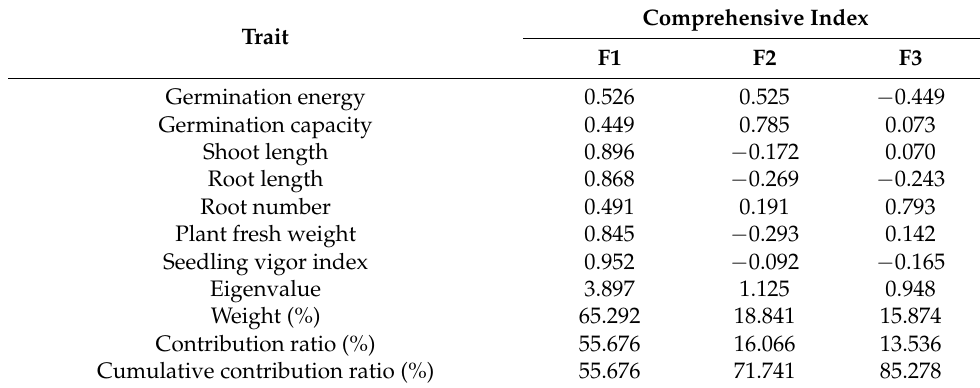
Figure 1. Determination of the optimal sodium chloride concentration for evaluating salt tolerance. The sodium chloride concentration of the salt injury index is 0.5 of the germination energy ( A ), germination capacity ( B ), shoot length ( C ), root length ( D ), root number ( E ), plant fresh weight ( F ), seedling vigor index ( G ), and the average of seven rice germplasms under different sodium chloride concentrations ( H ). Data in the figure are the means for each parameter under salt stress. Table 1. Eigenvector of comprehensive indexes and